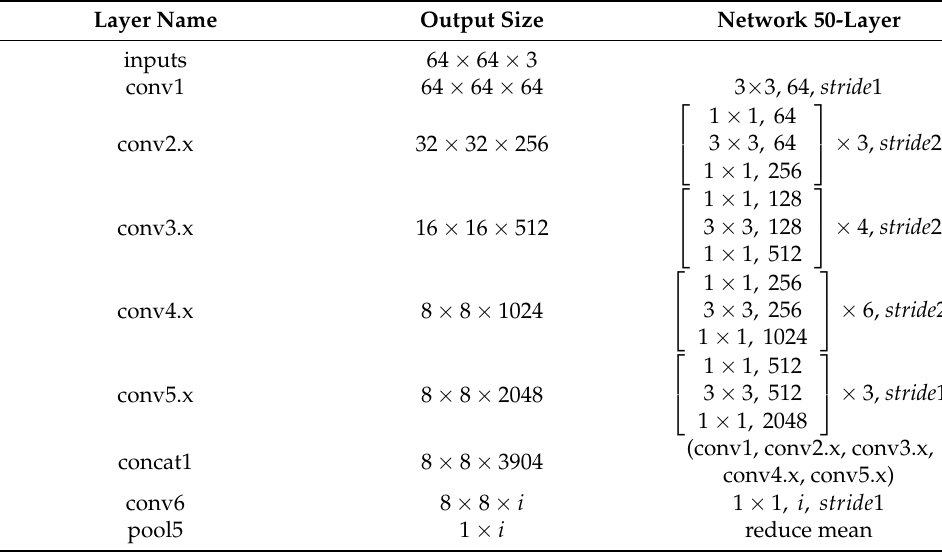
Table 2. Network architecture modified based on ResNet-50.